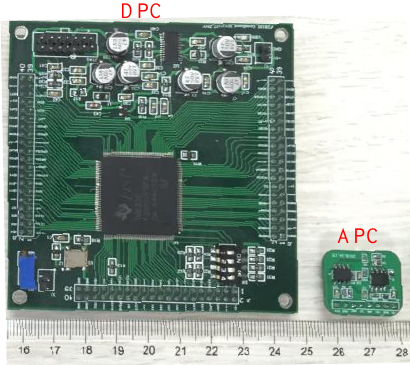
Figure 18. Photograph of two proposed controllers.